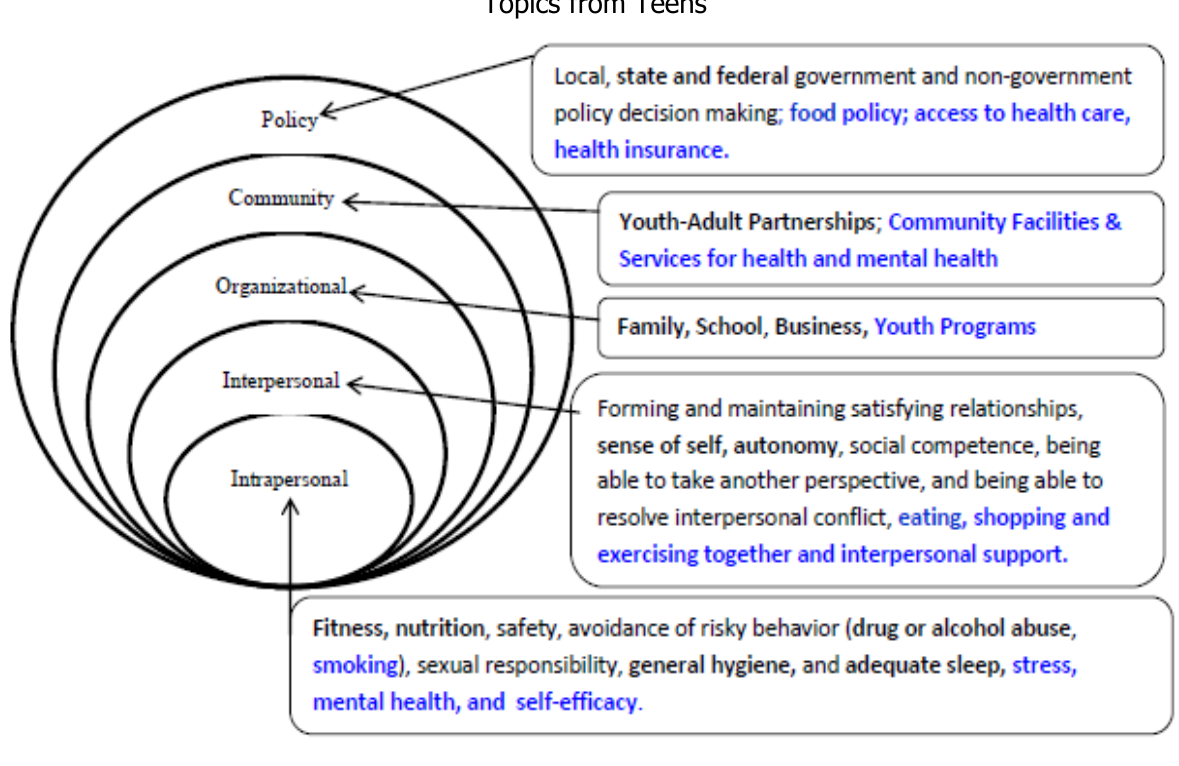
National 4-H Healthy Living Social Ecological Model with Additional Suggested Topics from